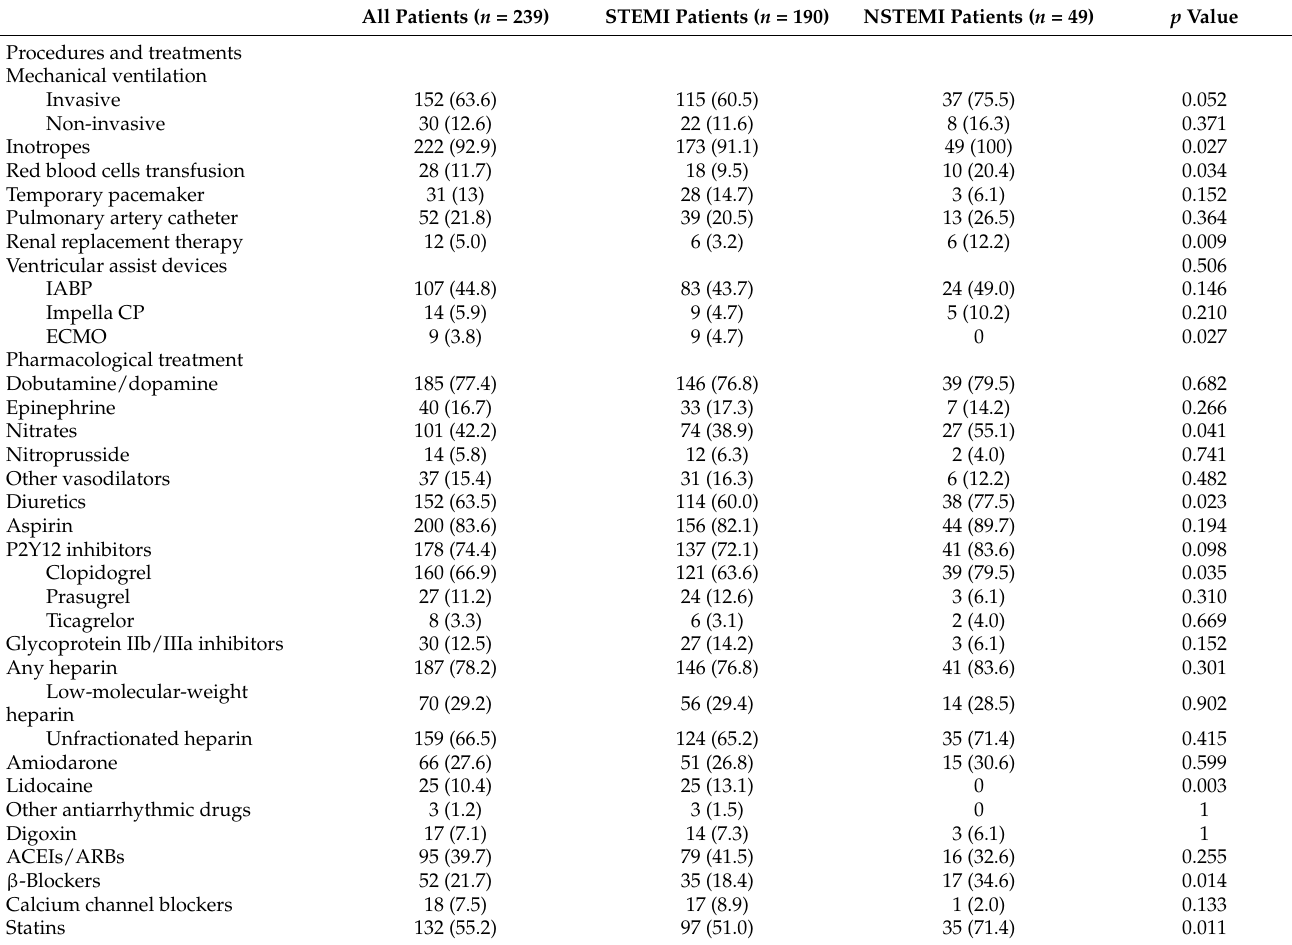
Table 3. Acute cardiovascular care unit procedures and medical